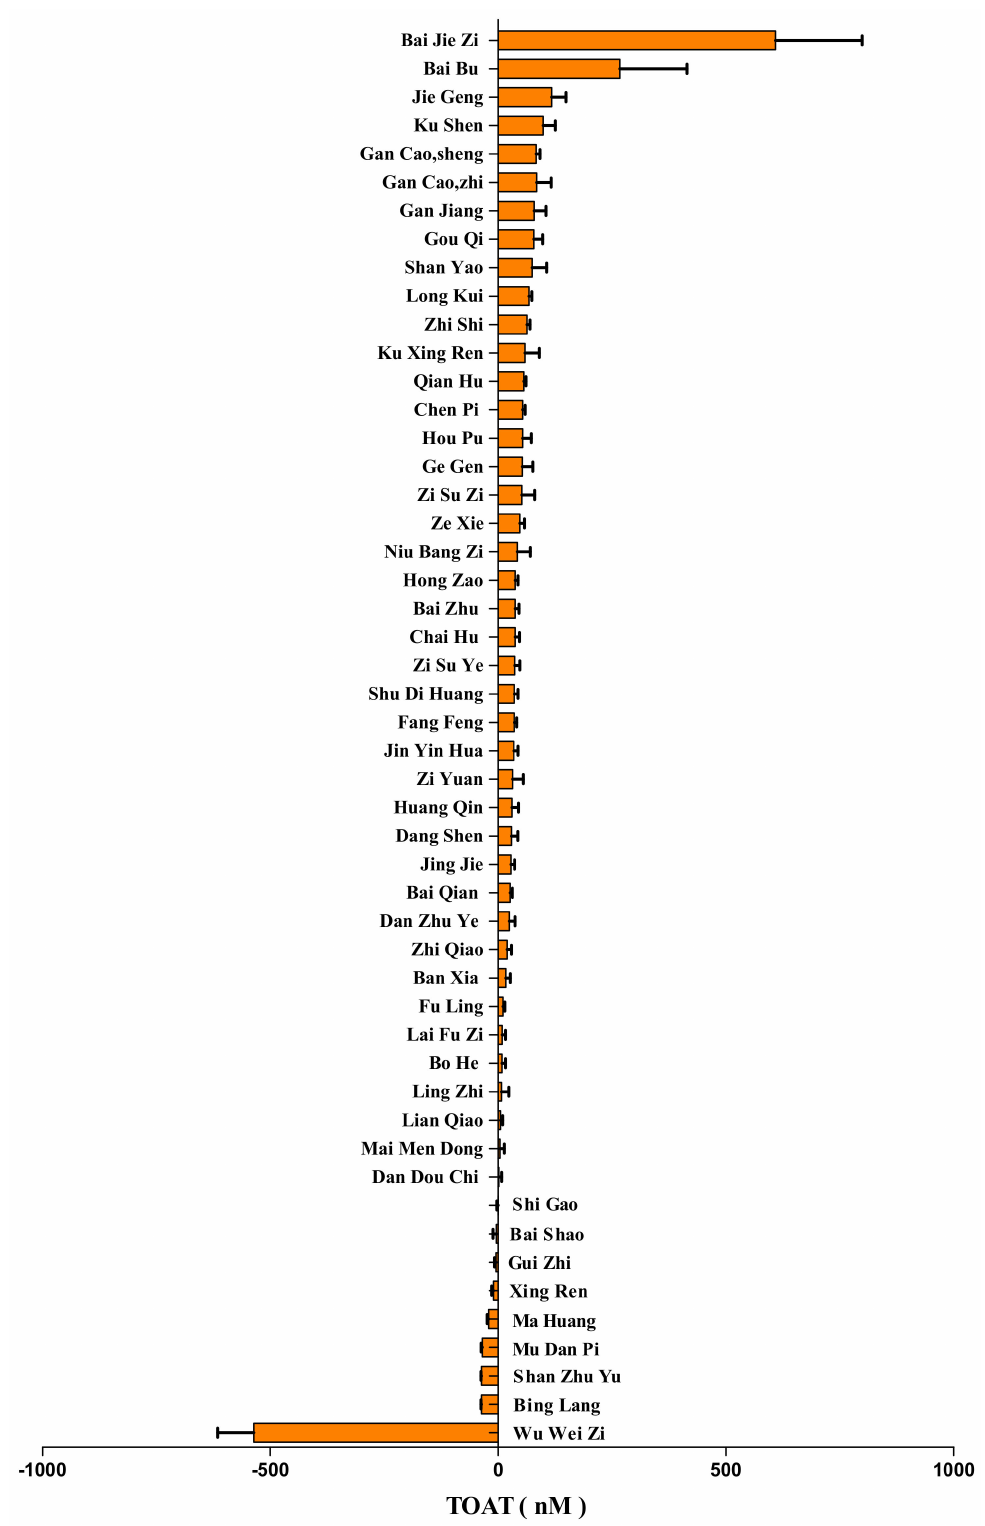
Figure 3. The TOAT of herbs used in Traditional Chinese Medicine (TCM). The TOAT of 50 herbs used in TCM. Data are shown as mean ± S.E.M. ( n =